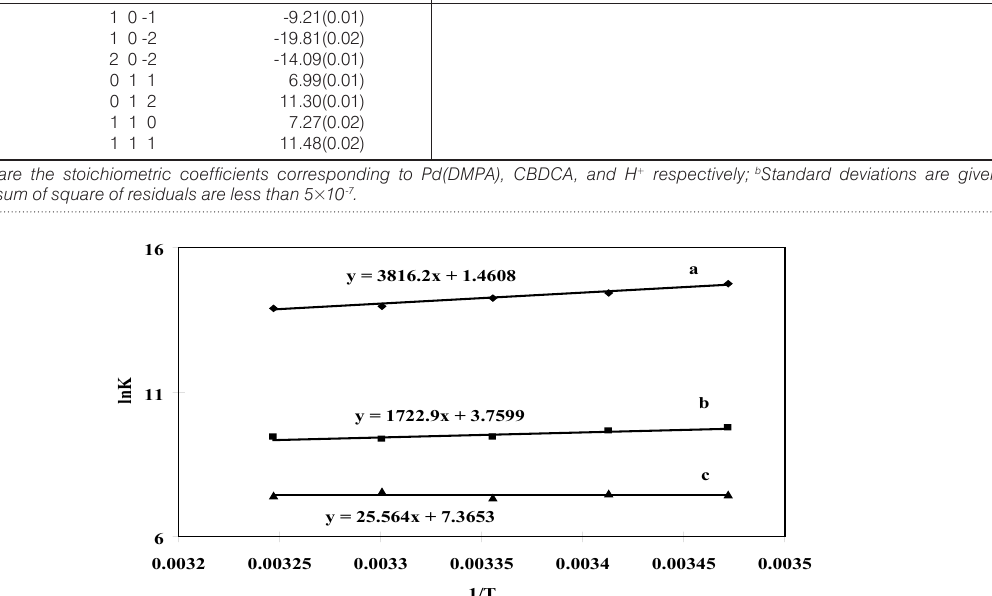
O) ] 2+ , where a, b and c correspond to Reactions 1, 2 and 3 in Table 5, 2 2